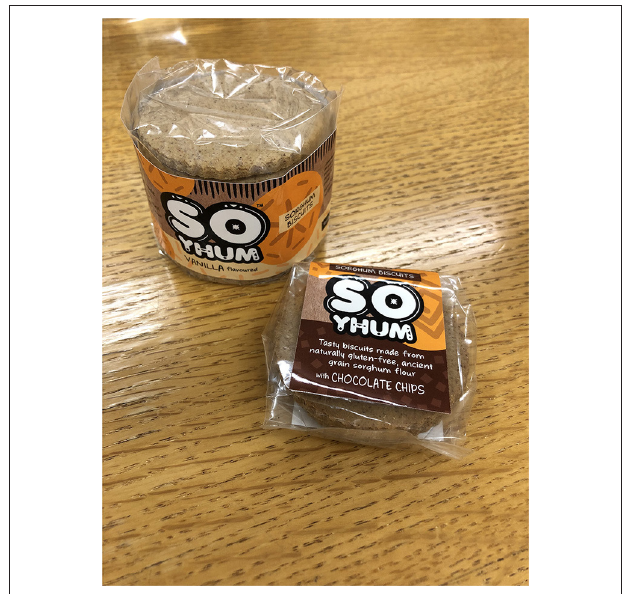
FIGURE 5 | Image of So Yhum! Sorghum biscuit products produced by researchers at the University of Pretoria.